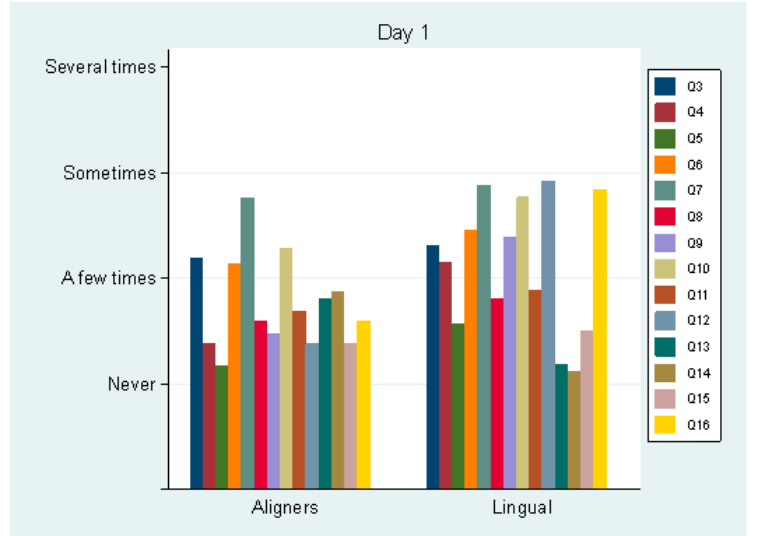
Figure 1. Average values of questions 3–16 by group, the first day following appliance